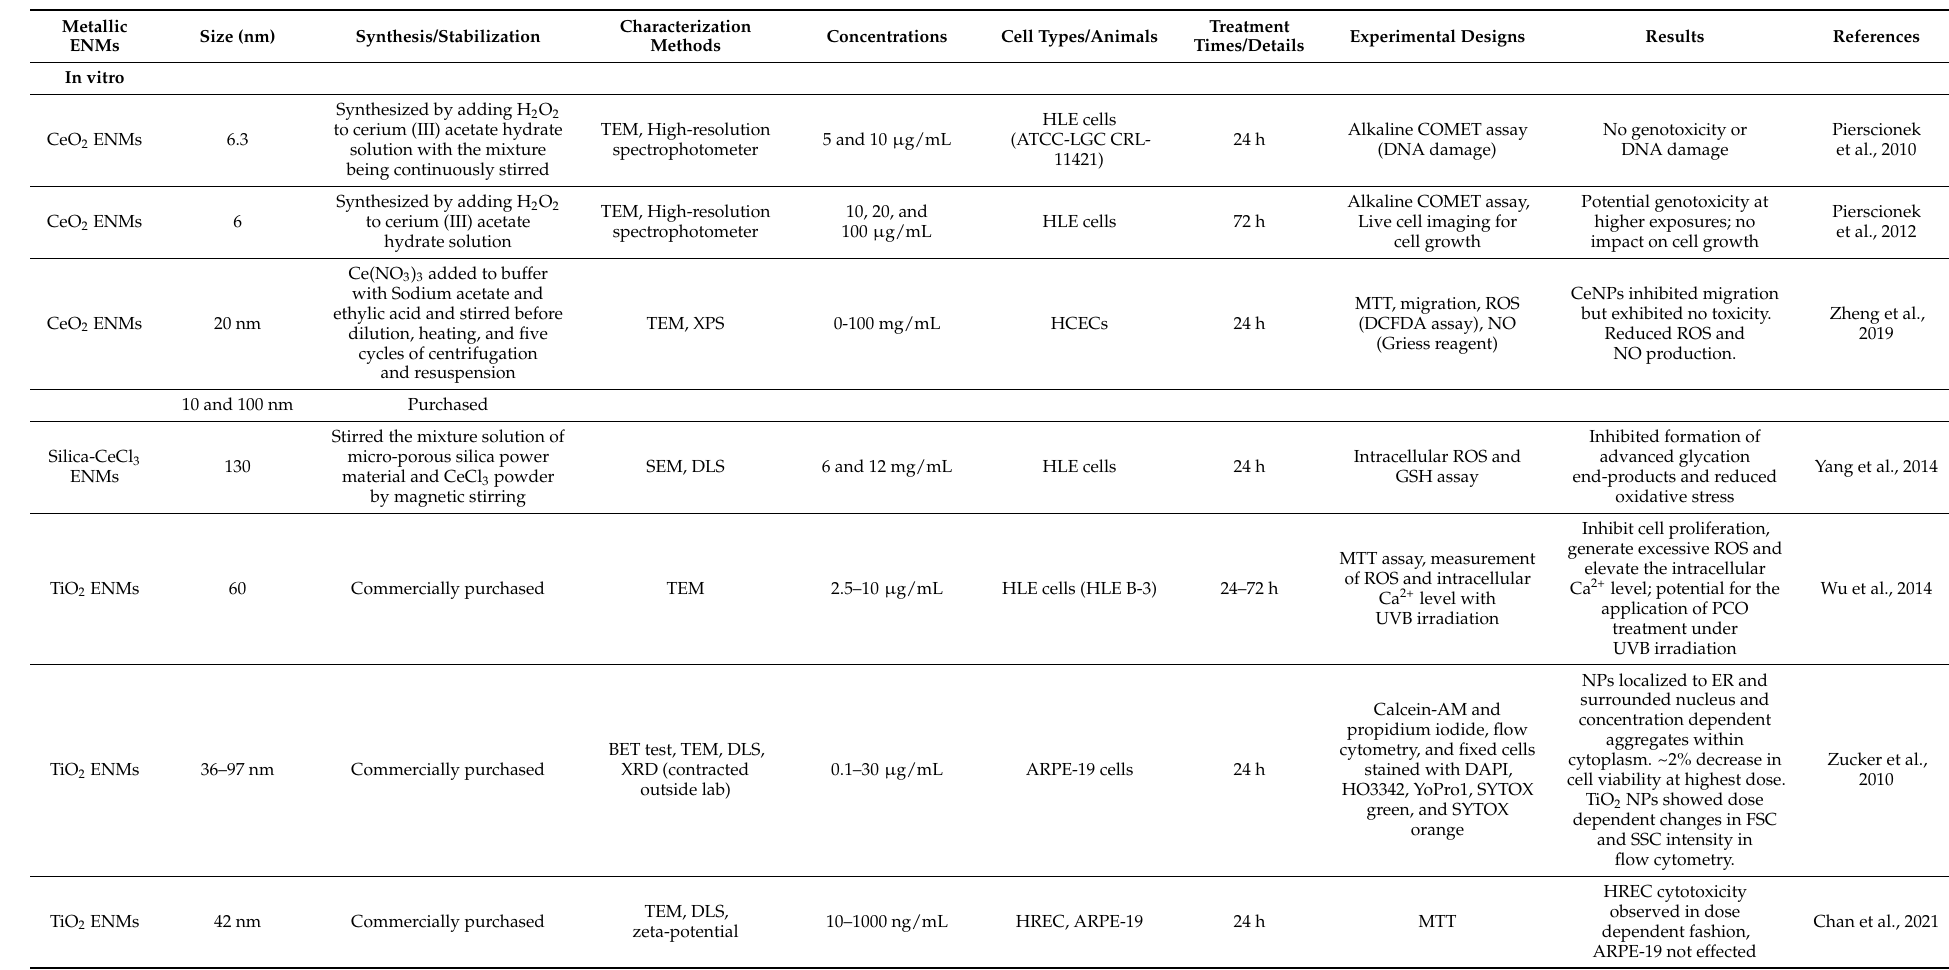
Table 3. Published studies utilizing other metallic ENMs in